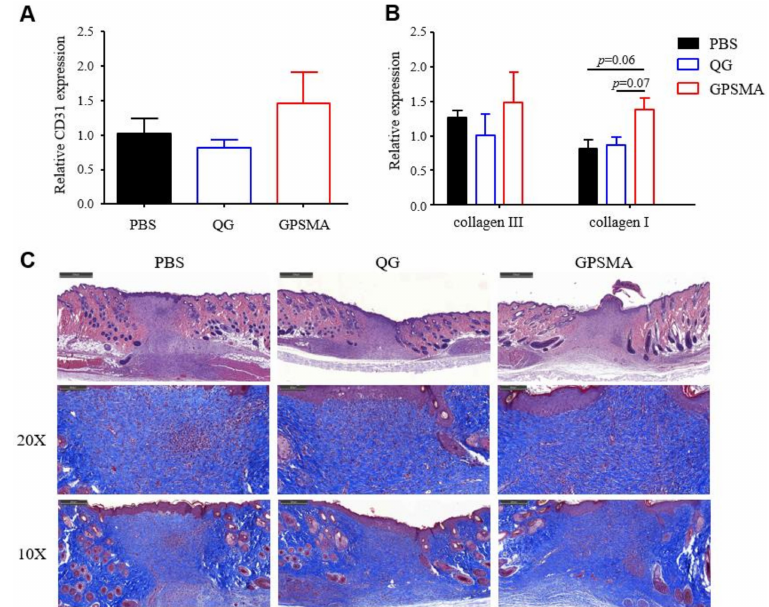
Figure 8. The e ff ects of QG and GPSMA on granulation development. ( A ) The CD31, ( B ) collagen I, and collagen III levels were analyzed by Western blot analysis. Data are reported as the mean ± SD. In terms of the collagen I level, the p -values were 0.06 and 0.07 for the GPMSA group compared to the PBS group and the QG group using unpaired tests, respectively. ( C ) Histological section taken on day 13 stained with H&E and Masson’s trichrome. The collagen is stained blue, and the muscle tissue is stained red. Scale bar: 500 µ